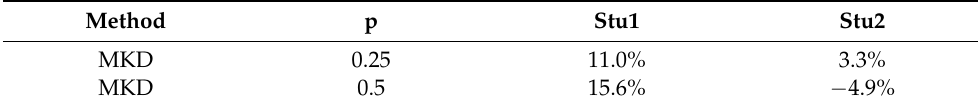
Table 4. The RERR of proposed MKD compared with S-KD.